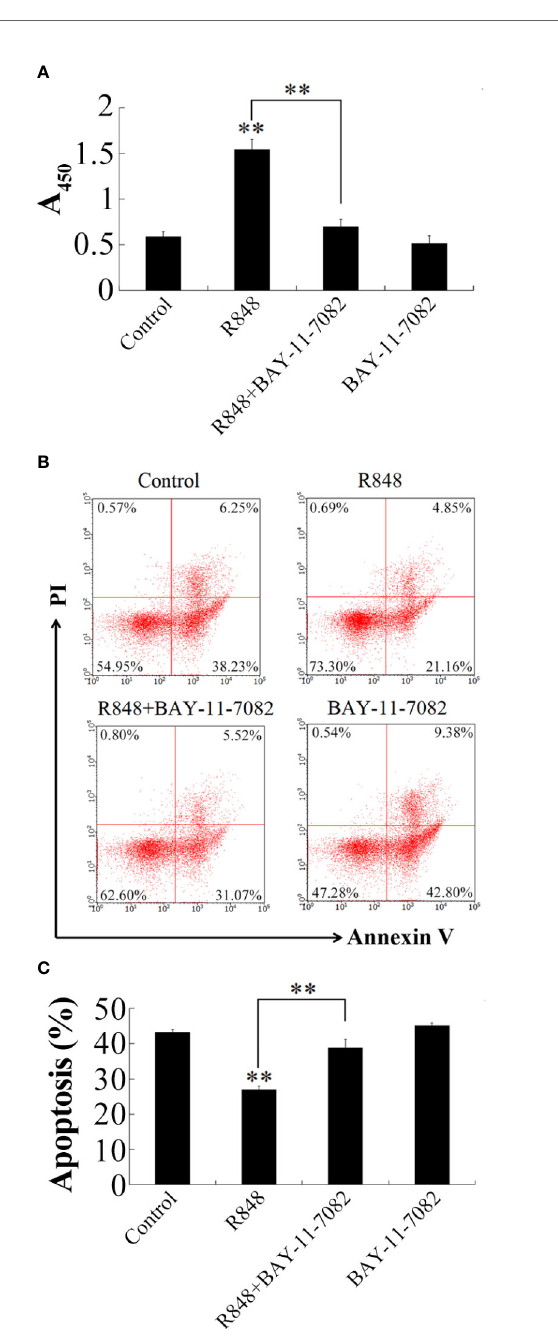
FIGURE 6 | Effect of BAY-11-7082 on R848-induced cellular activity. (A) Golden pompano HKLs were treated with PBS (control), R848, BAY-11- 7082, or R848 plus BAY-11-7082. The cells were then determined for proliferation (A) , apoptosis (B) , and statistic bar chart of the apoptosis percentage (C) . Data in (A) are presented as means ± SEM (N = 3), and (C) are presented as means ± SD (N = 3). **P < 0.01. Data in (B) are one representative of three independent reduced; however, R848 did not have direct antimicrobial activity. These results suggested that R848 induced the immune responses against bacteria in golden pompano.